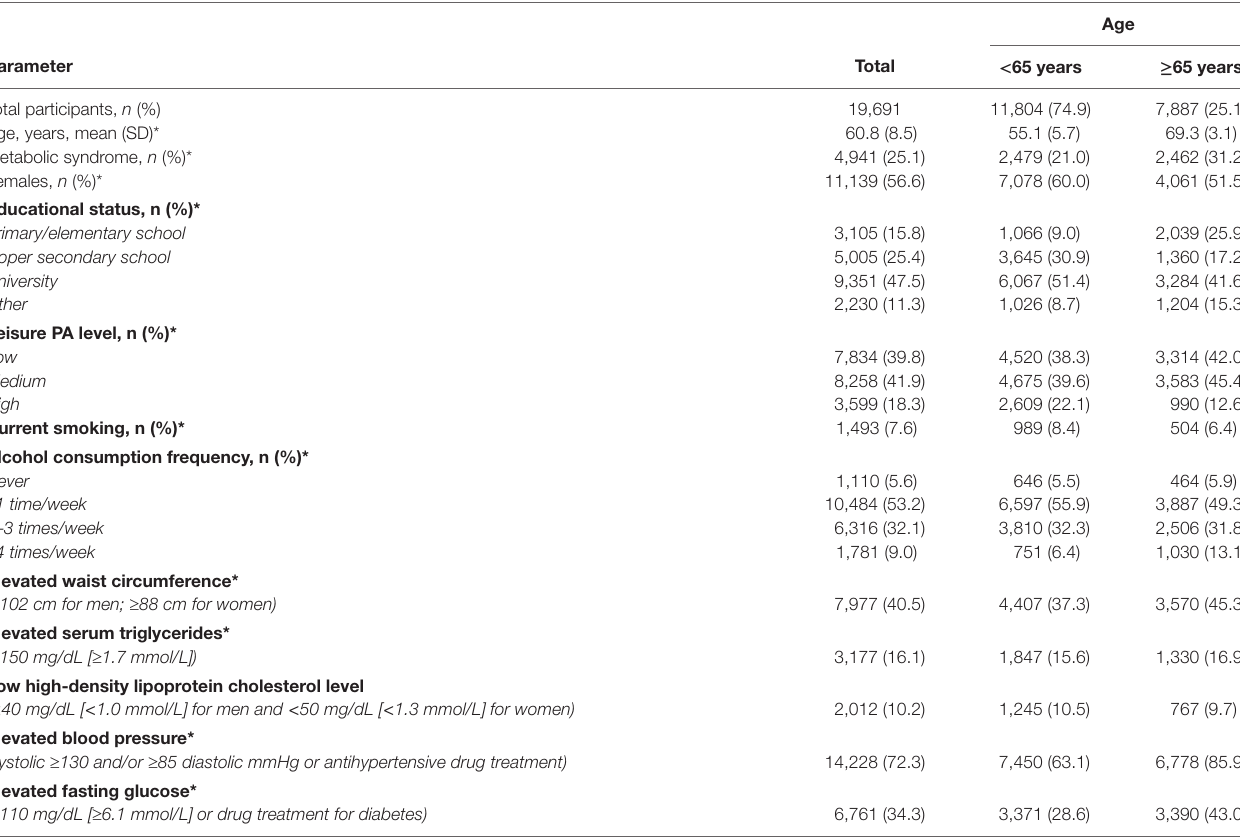
TaBle 1 | Participants’ characteristics, stratified by age.